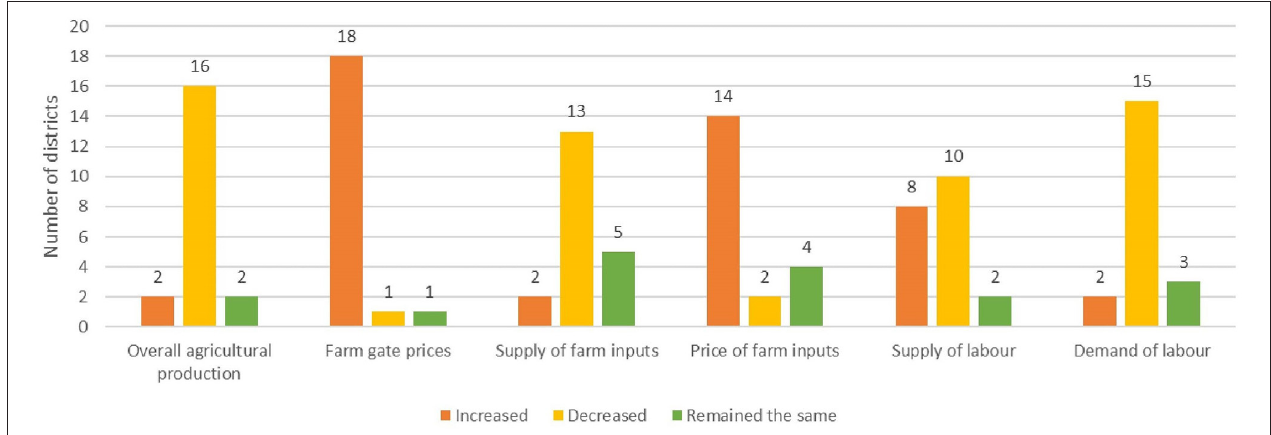
FIGURE 5 | Impact assessment of COVID-19 pandemic on agricultural production in Jharkhand. Source: NABARD